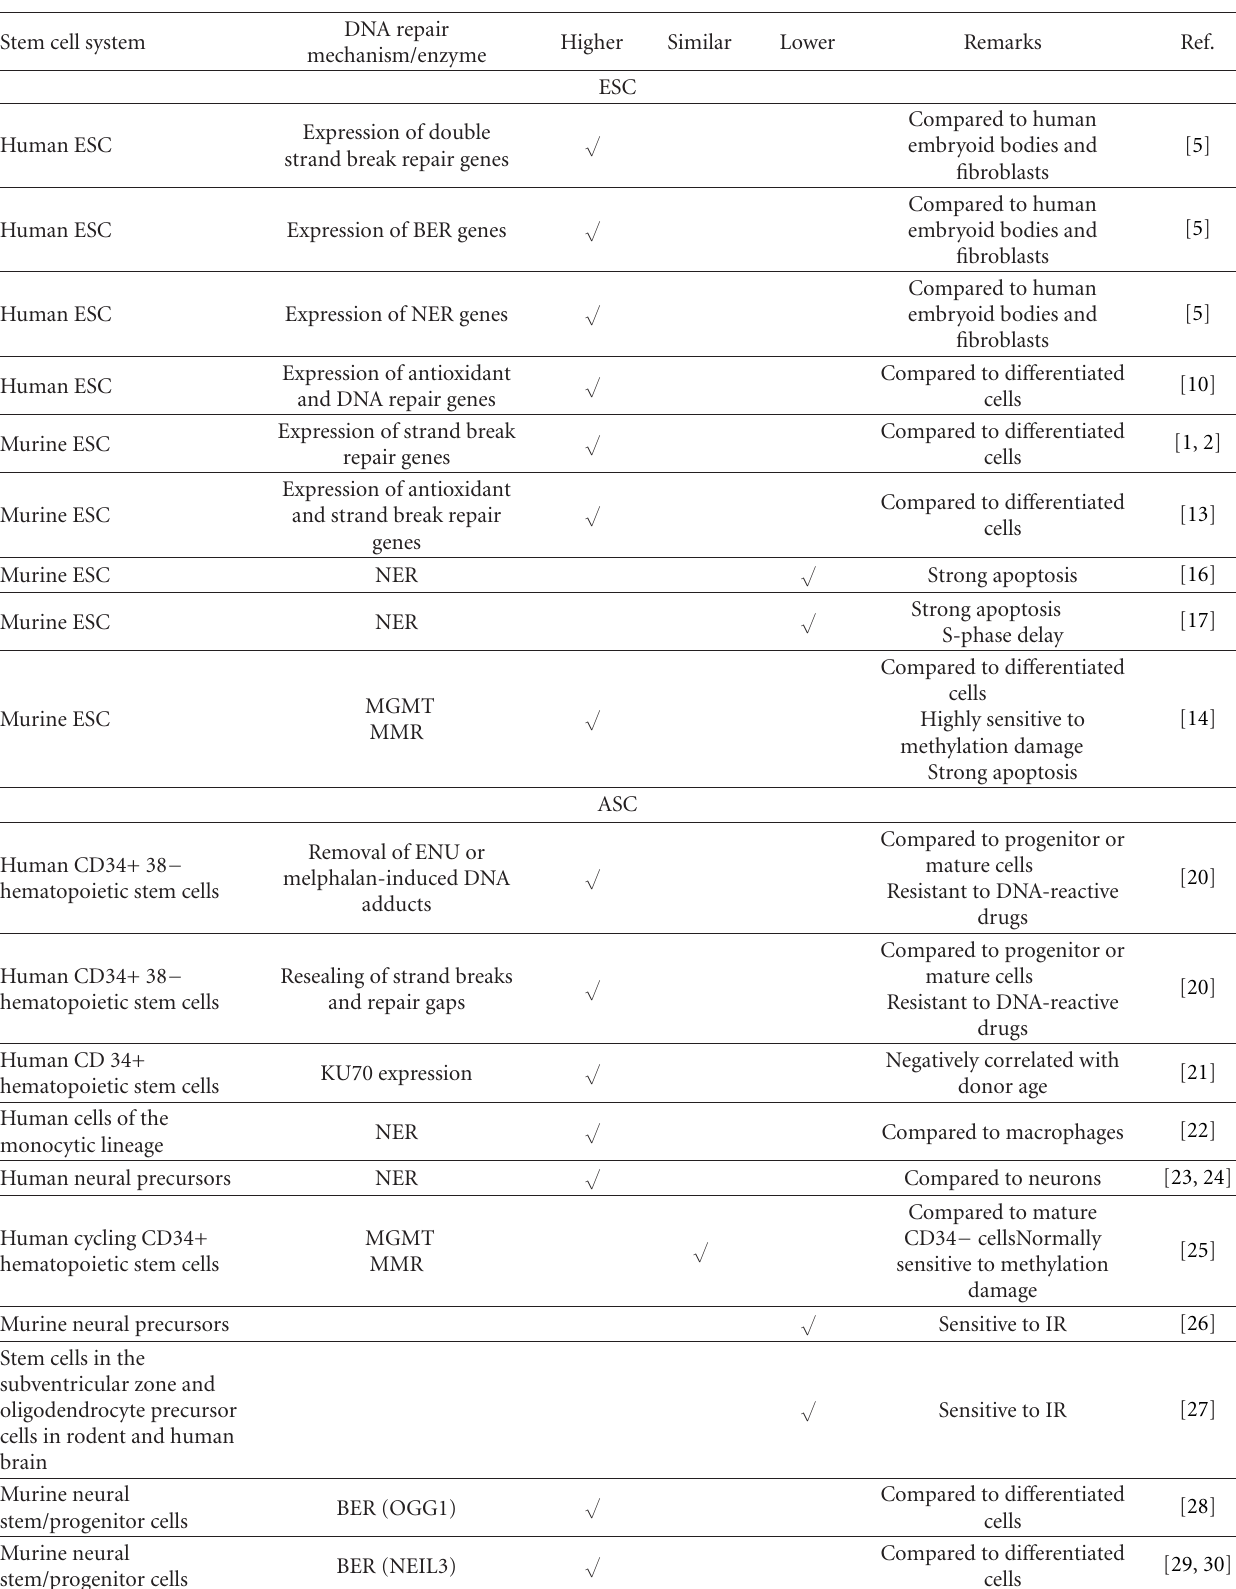
Table 1: DNA repair capacity in embryonic, adult and mesenchymal stem versus di ff erentiated